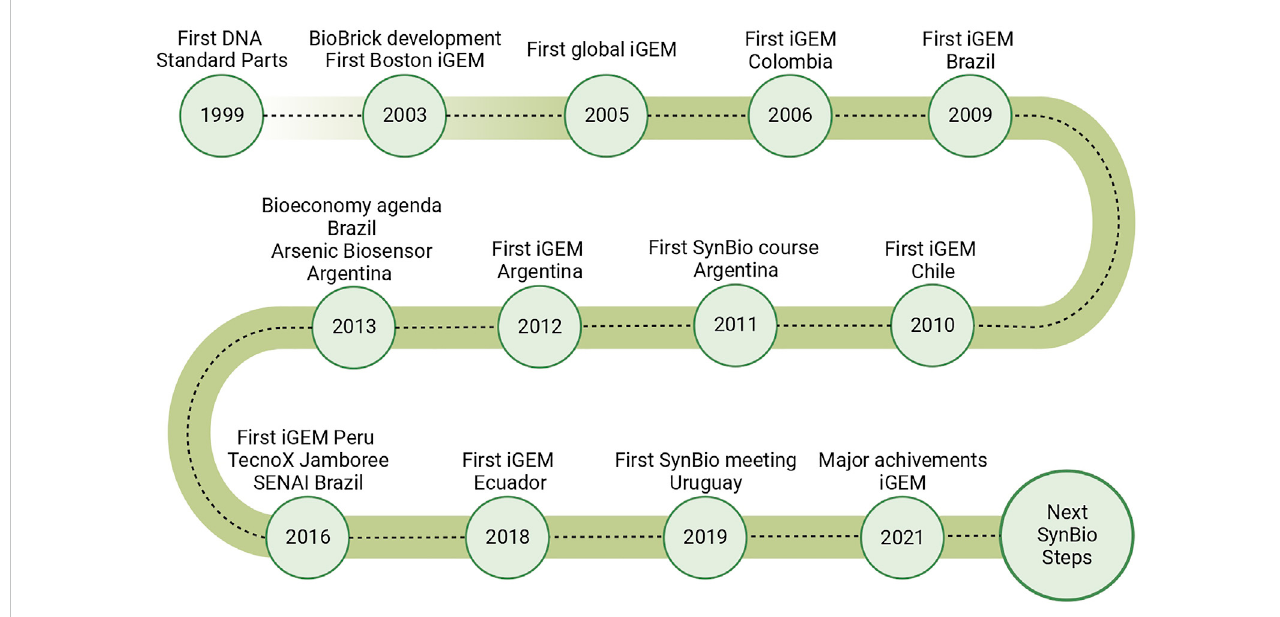
Collection of the leading milestones of SynBio globally and in South